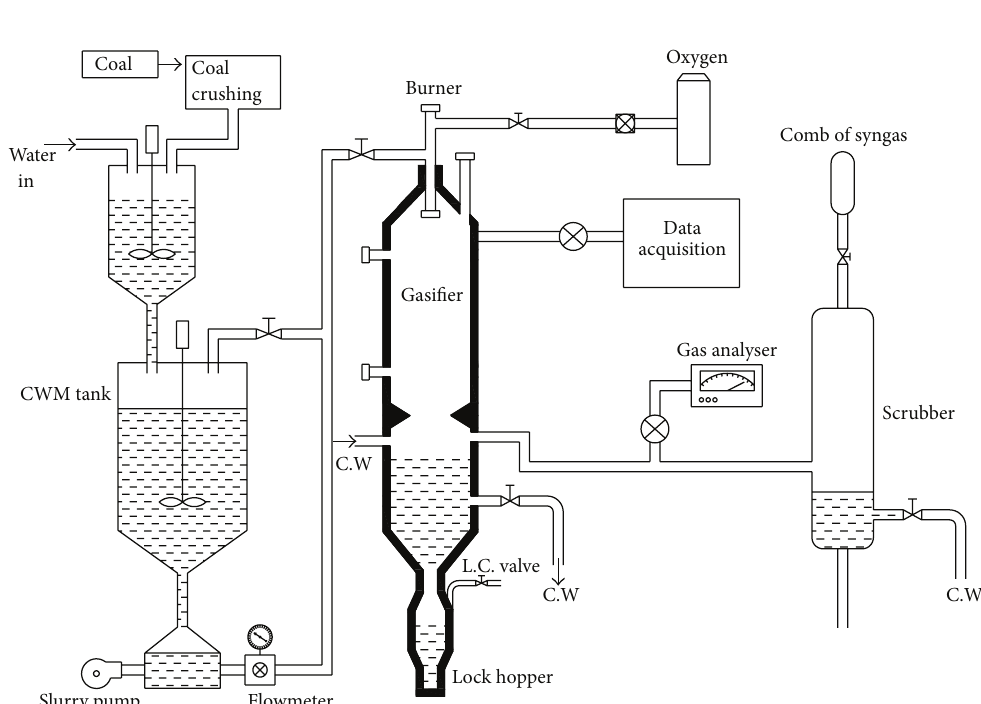
Figure 3: Entrained-flow coal gasification process—slurry feed type [5].